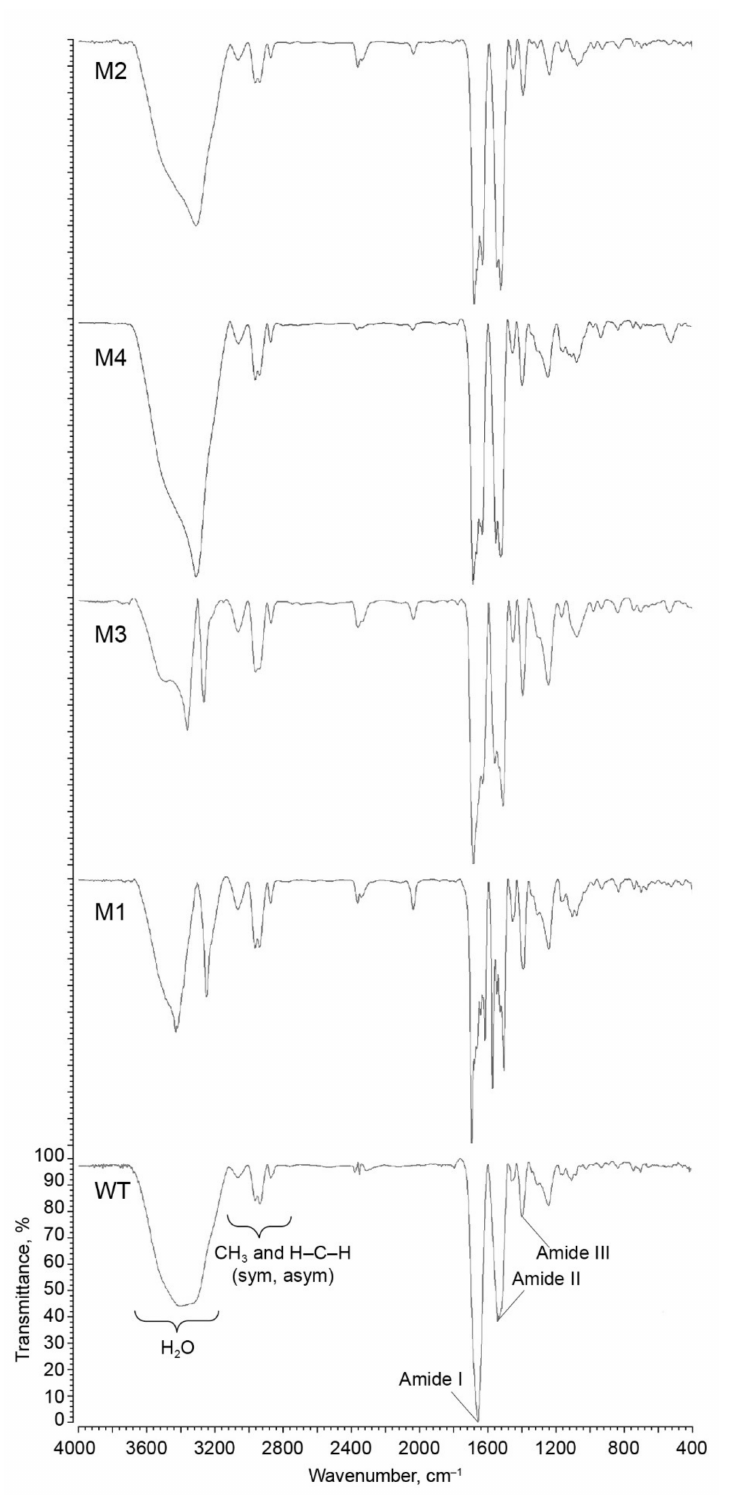
Figure 4. The IR spectra of cytochrome c (WT) and its mutant variants (M1-T78N/K79Y/ M80I/I81M/F82N, M2-T78S/K79P, M3-I81Y/A83Y/G84N,